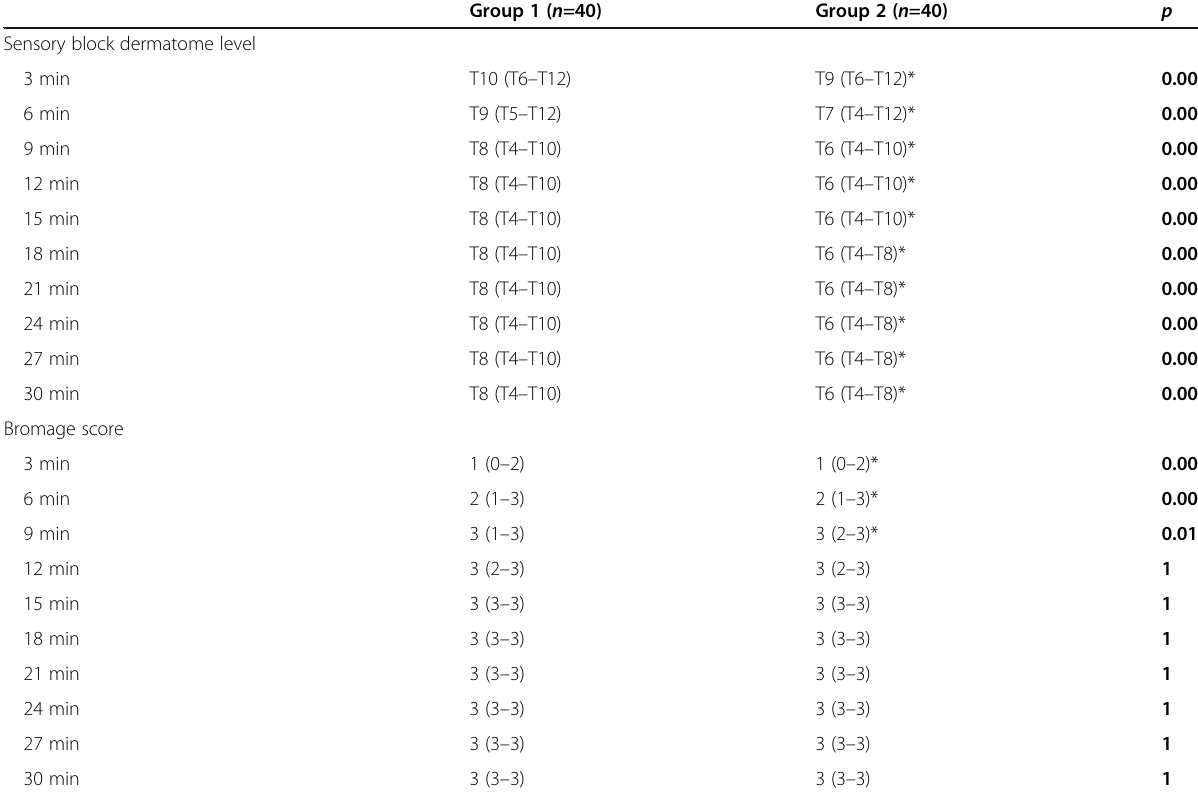
Table 2 Sensory and motor block (Bromage score) profile after intrathecal injection